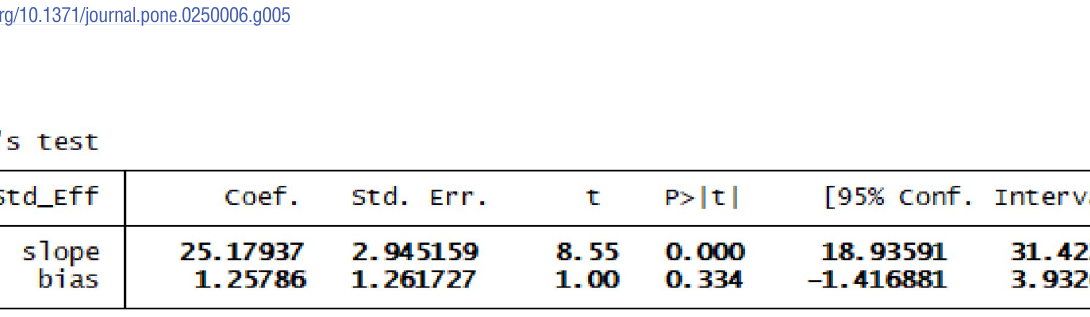
Fig 6. Publication bias on the magnitude of ventricular septal defect among congenital heart defect patients in East Africa from January 2000-October, 2020.